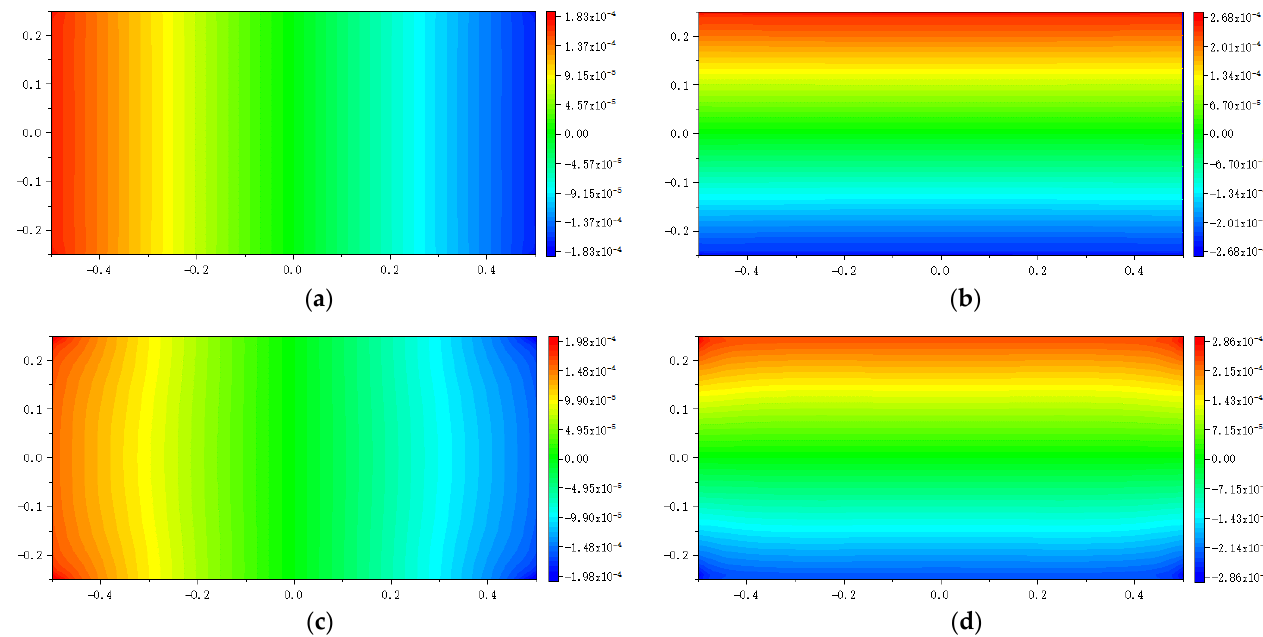
Figure 9. The displacement along central lines of the rectangular plate subjected to tension: ( a ) u x along y = 0; ( b ) u y along x = 0.